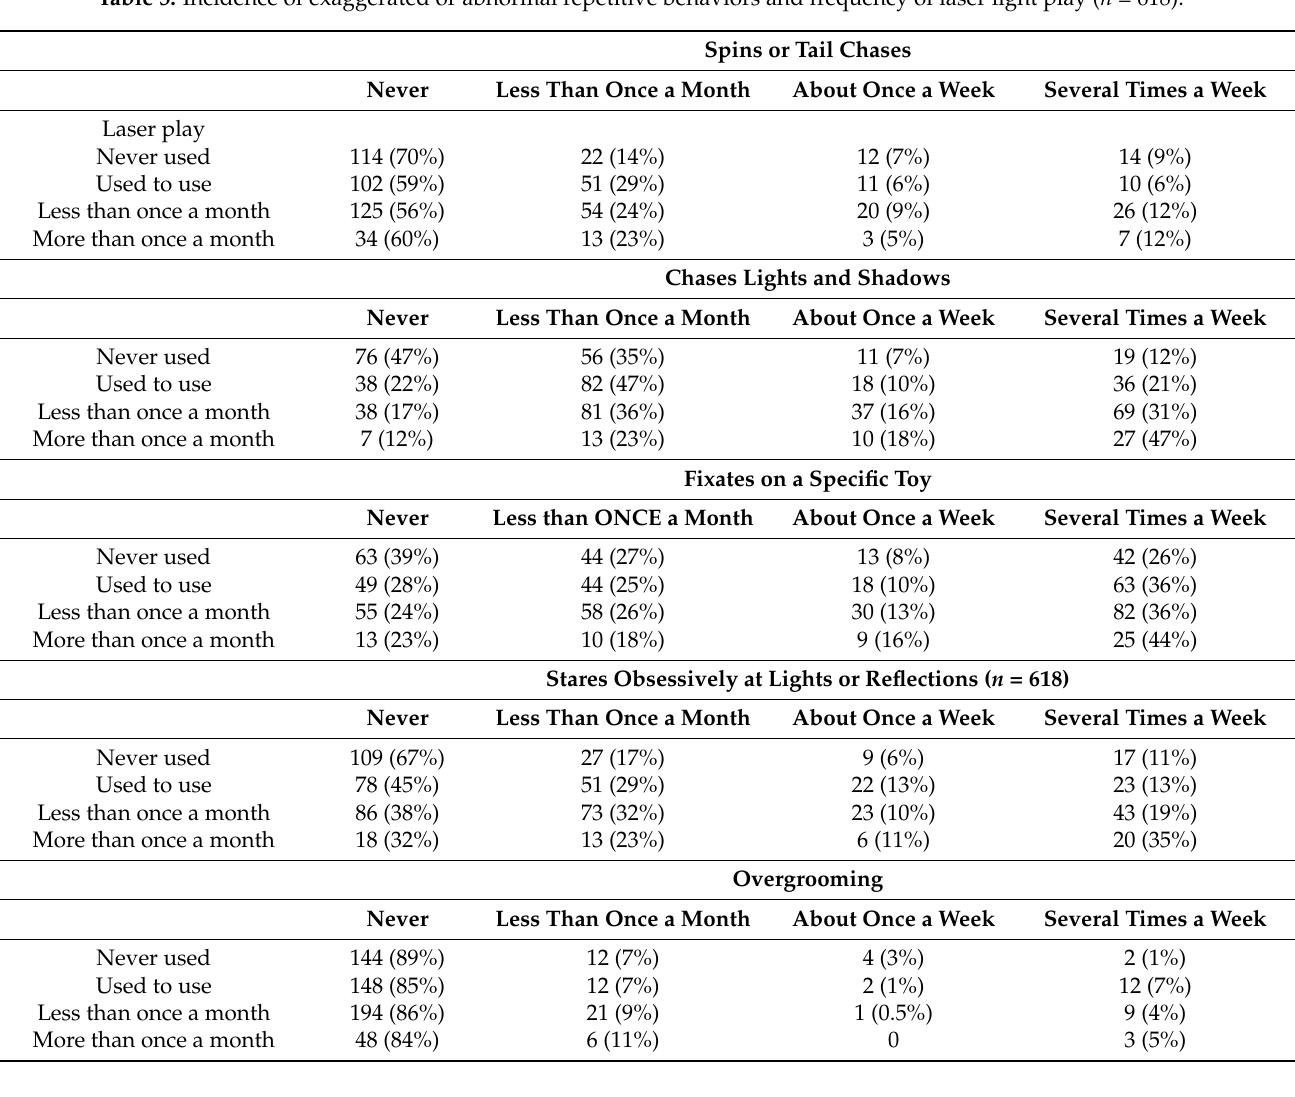
Table 5. Incidence of exaggerated or abnormal repetitive behaviors and frequency of laser light play ( n =